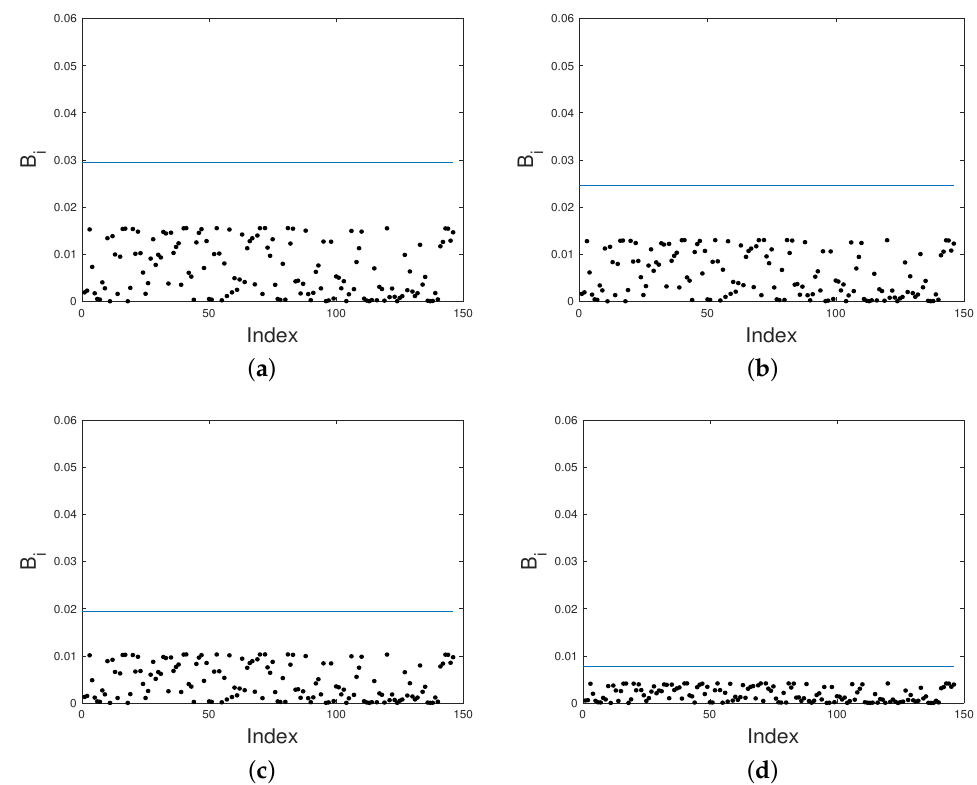
Figure 8. Index plots of B i for assessing local influence on (cid:98) α ( a ); (cid:98) β 1 ( b ); (cid:98) β 2 ( c ); and (cid:98) φ ( d ) under explanatory variable perturbation for Student-t PVCM (Santiago data). Table 3. Relative changes (%) on (cid:98) α 0 , (cid:98) α 1 and ˆ φ Student-t PVCM. Dropped (cid:98) α